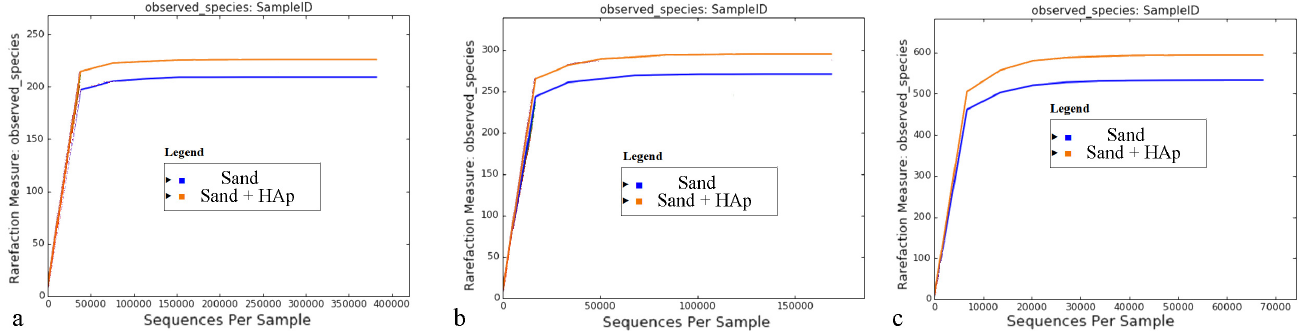
Figure 5. Rarefaction curves showing the total numbers of families ( a ), genera ( b ) and species ( c ) detected in the soil sample before (blue curves) and after (orange curves) the treatment with HAp nanoparticles.